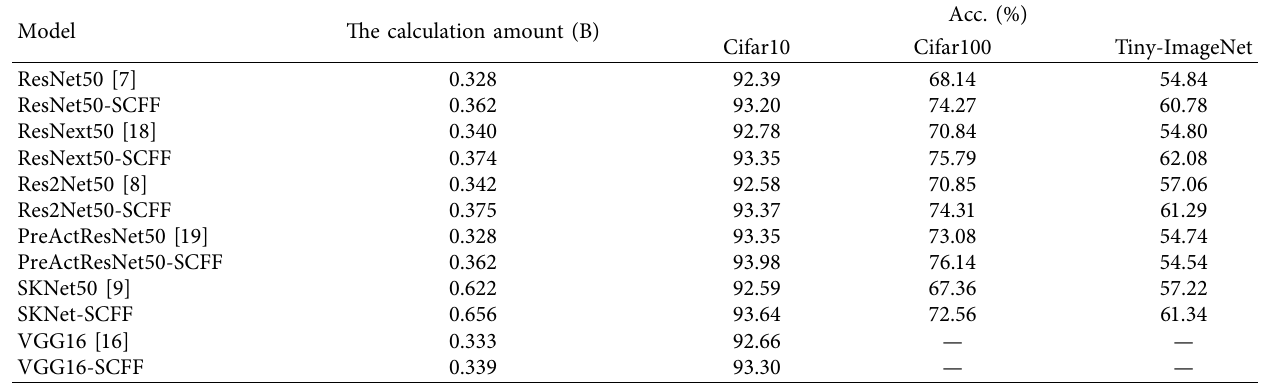
Table 3: Comparative experiment.